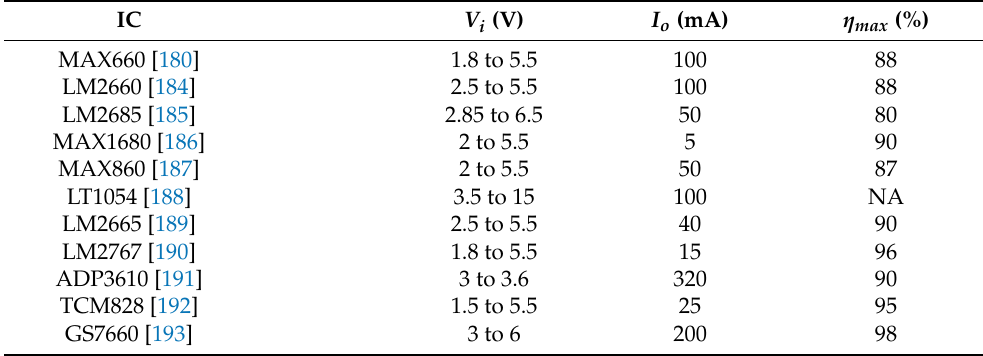
Table 6. Parameters of SCVD